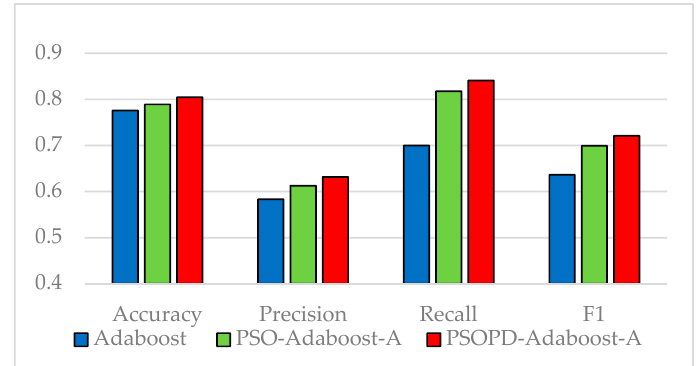
Figure 9. Performance Comparison of the AdaBoost, PSO-AdaBoost-A, and PSOPD-AdaBoost-A on Horse Colic Dataset.